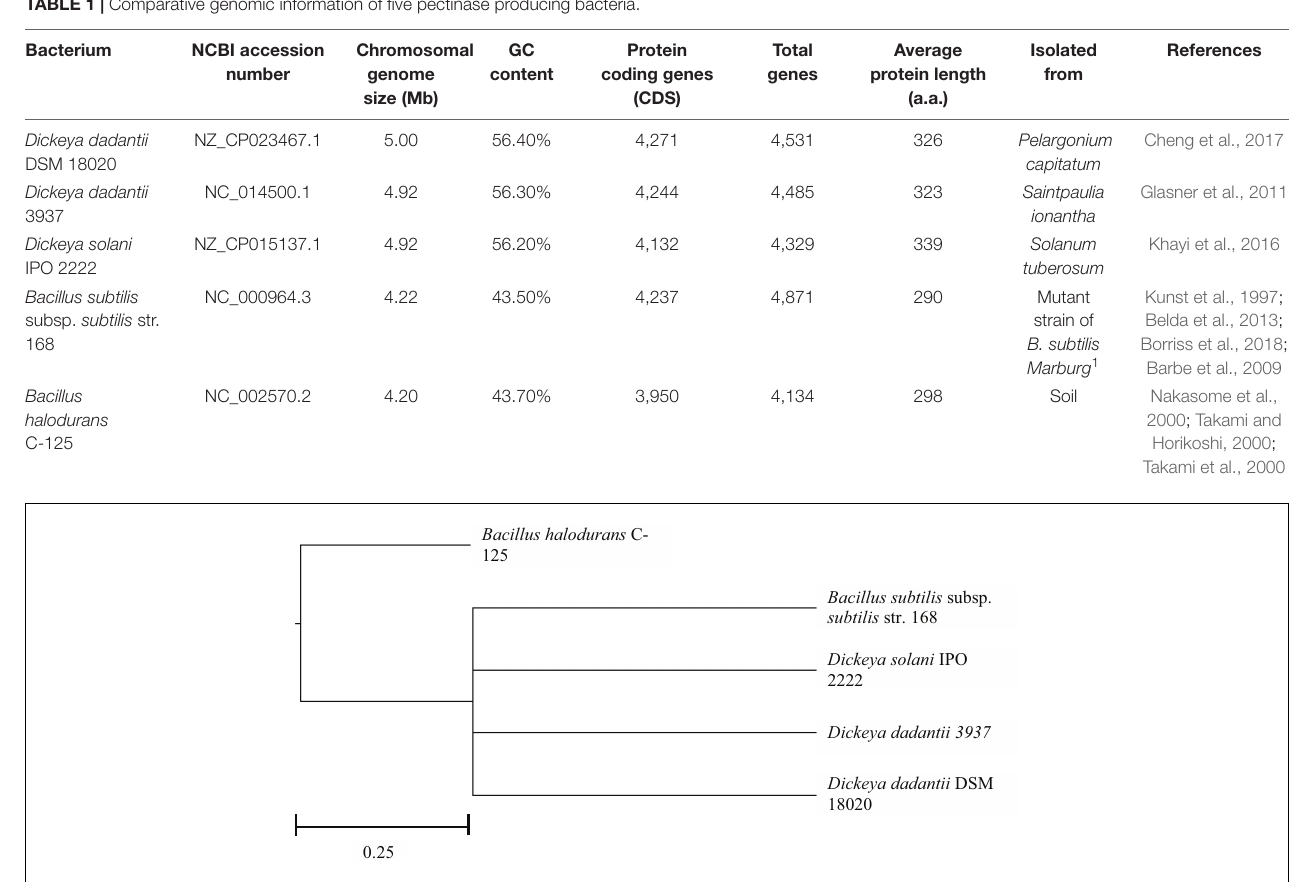
FIGURE 1 | Rooted phylogenic tree of five pectinase-producing bacteria after multiple alignment in MAUVE.